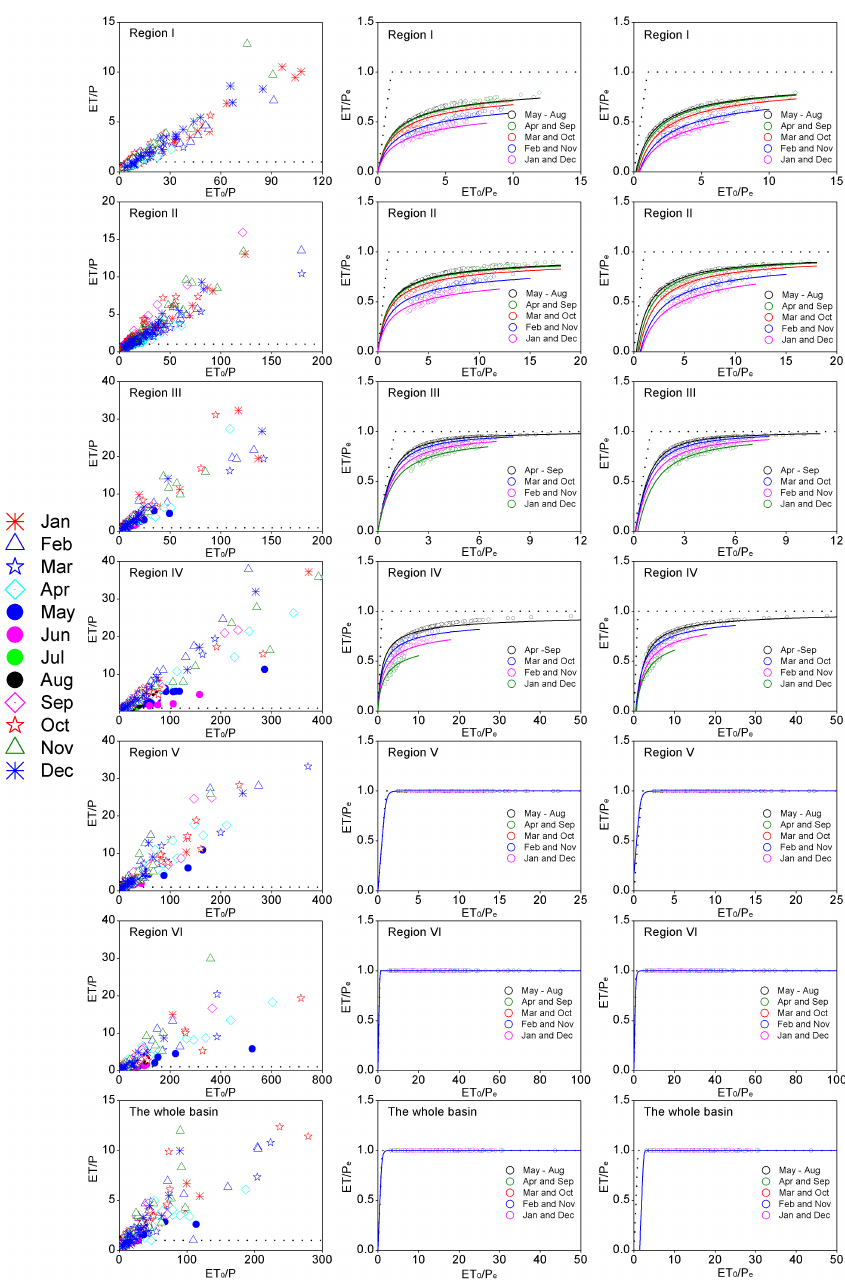
Figure 9. Comparison of the original Budyko curves (left panel) and the new Fu-type Budyko curves (middle panel, with λ = 0) and the new Fu-type Budyko curves (right panel, with λ >0) for regions I–VI and the whole basin at the monthly